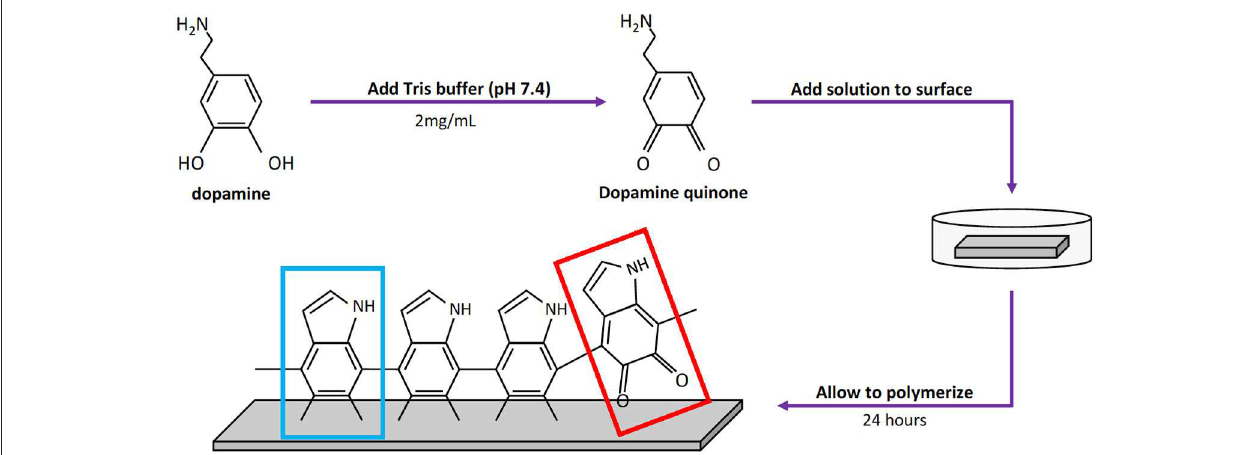
FIGURE 1 | Process used to coat 316L Stainless Steel (SS) samples with poly-dopamine (pDA). To coat 316L SS samples, a pDA solution (2 mg/mL) was made using dopamine-HCl and a tris-HCl buffer (pH 7.4). After the tris-HCl buffer is placed onto the dopamine-HCl the dopamine will begin to oxidize immediately, creating a dopamine quinone. The solution is then placed on top of a 316L SS coupon and is allowed to polymerize for 24h. Two forms of pDA will form: 5,6-dihydroxyindole (blue box) or 5,6-indolequinone (red box). The type of pDA found in the red box will not adhere to the surface of the metal.